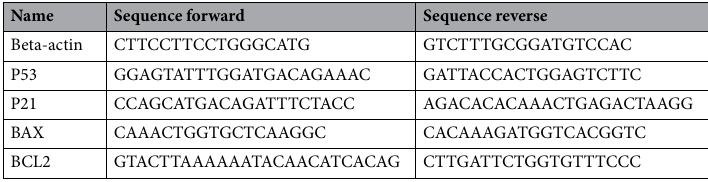
Table 1. The sequence of Beta-actin, P53 , P21 , BAX , and BCL2